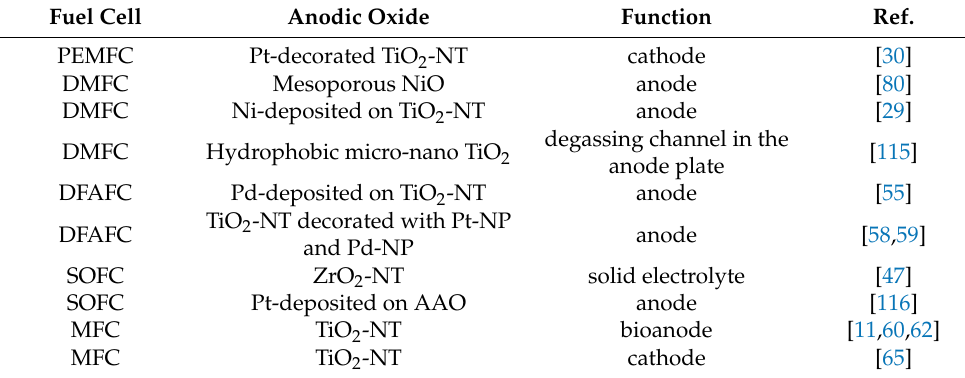
Table 4. Anodic oxides produced via anodization technique explored in or tested for fuel cell applications. Fuel